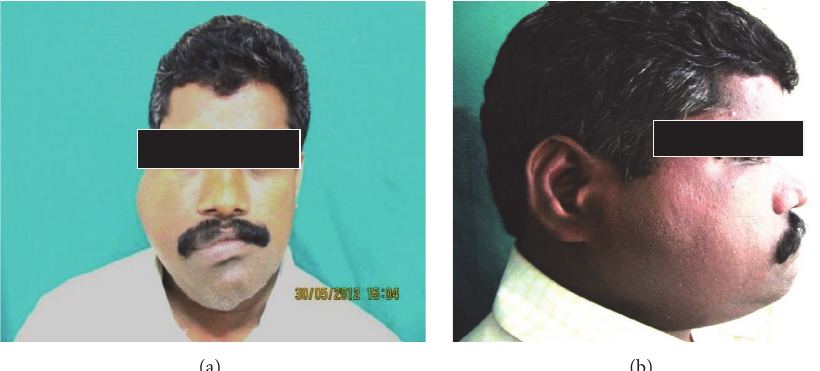
Figure 1: ((a) and (b)) Extraoral examination of the patient exhibiting a diffuse swelling pertaining to hard and soft tissues of right side of the face.